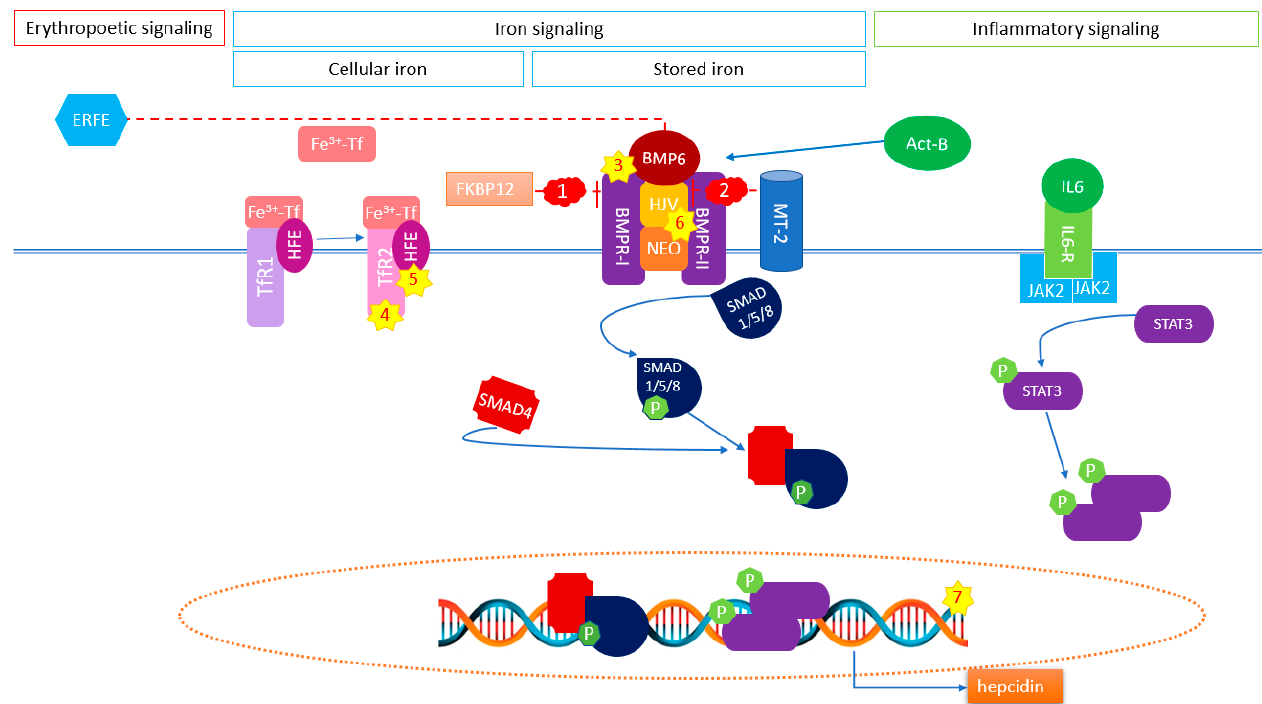
Figure 1. Schematic view of hepatic hepcidin regulation by BMP/SMAD pathway and proposed potential candidate genes contributing to polygenetic inheritance in monoallelic IRIDA . Expres- sion of hepcidin is regulated via the BMP/SMAD pathway, which is activated by BMP receptors that bind with BMP coreceptor hemojuvelin (HJV), leading to phosphorylation and translocation of the intracellular SMAD proteins to the nucleus. Here they act as transcription factors increasing HAMP mRNA transcription. Hepcidin expression via this pathway is modulated by three main mechanisms: erythropoiesis, inflammation, and iron (stored and circulating). Potential candidate genes in these pathways contributing to polygenetic inheritance are indicated by numbers (1 to 7). It is conceivable that gain of function mutations of positive regulatory factors and loss of function of inhibitors of the BMP/SMAD pathway (e.g., ACVR1 (ALK2)) can lead to an overactivation of the hepcidin response, leading to instability of the BMP pathway and, consequently, to a potential IRIDA phenotype: red clouds, loss of function (LoF); yellow stars, gain of function (GoF). Proposed genes are displayed by number: (1) FKBP1a (FKBP prolyl isomerase 1A) (LoF), (2) TMPRSS6 (transmembrane serine protease 6) (LoF), (3) BMPR1 (bone morphogenetic protein receptor type 1) (GoF), (4) TFR2 (transferrin receptor type 2) (GoF), (5) HFE (homeostatic iron regulator) (GoF), (6) HJV (hemojuvelin) (GoF), and (7) HAMP (hepcidin antimicrobial peptide) (GoF). Act-B, activin B; ERFE, erythroferrone; IL-6, interleukin 6; Fe 3+ -Tf, transfferin-bound iron; TfR, transferrin receptor; JAK2, Janus kinase 2—inhibiting